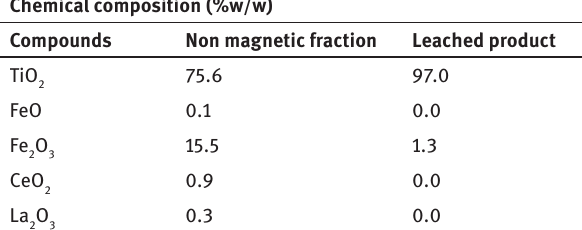
Table 4: Chemical composition comparison of the non-magnetic fraction of the Bomar ilmenite and the leached product after organic acids